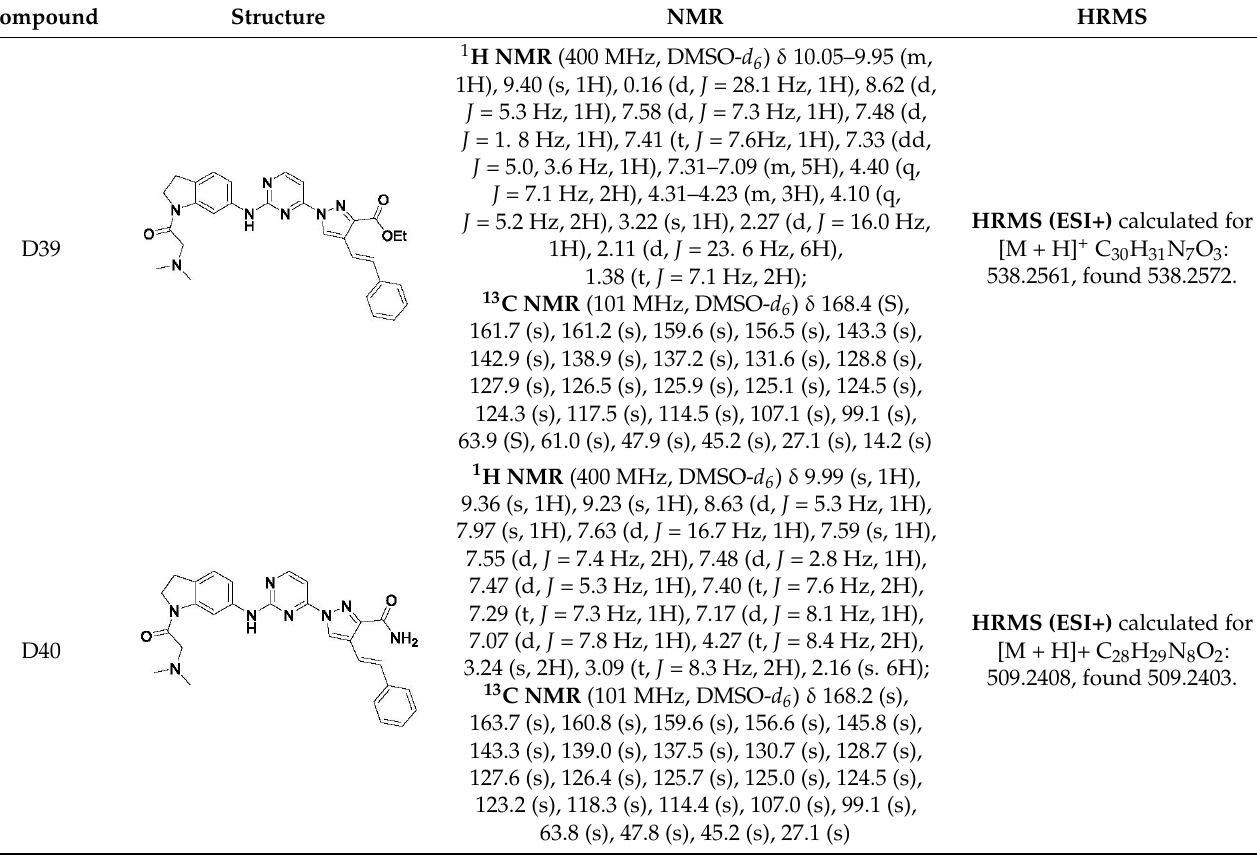
Table 4. The spectral data (NMR and HRMS) of the synthesized compounds. Compound Structure